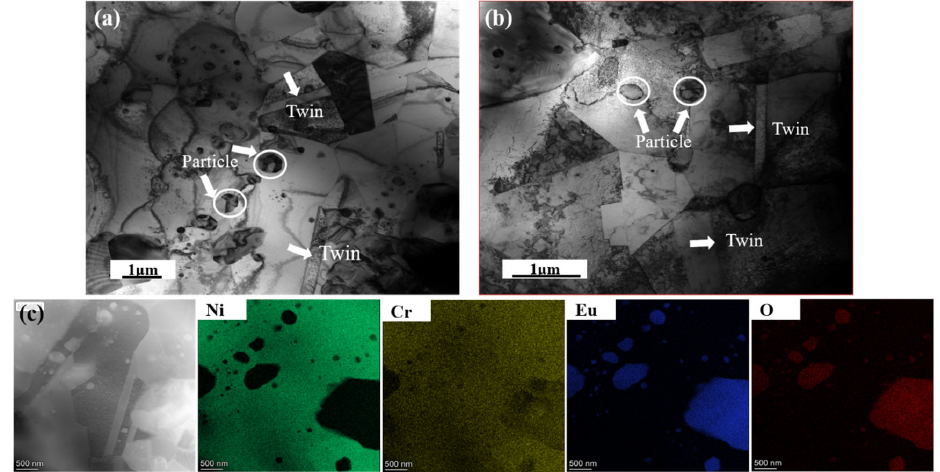
Figure 8. TEM images with the corresponding EDS mappings of the composites: ( a ) a bright TEM